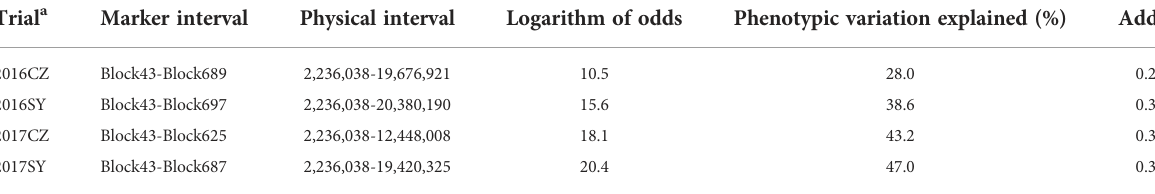
TABLE 2 QTL conferring brown hull color identi fi ed with the recombinant inbred line population of Yugu 5 × Jigu 31 in four fi eld trials. Trial a Marker interval Physical interval Logarithm of odds Phenotypic variation explained (%)